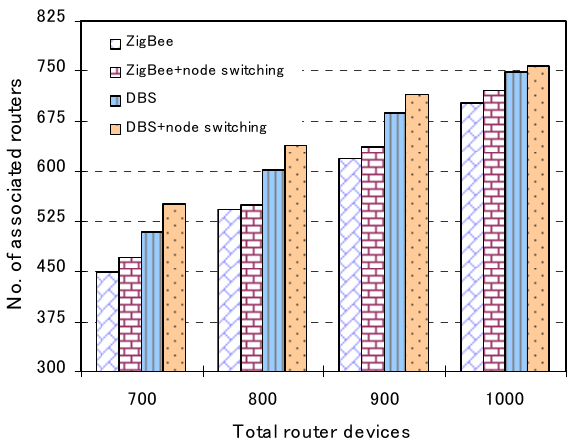
Figure 8. Number of associated routers for dynamic network